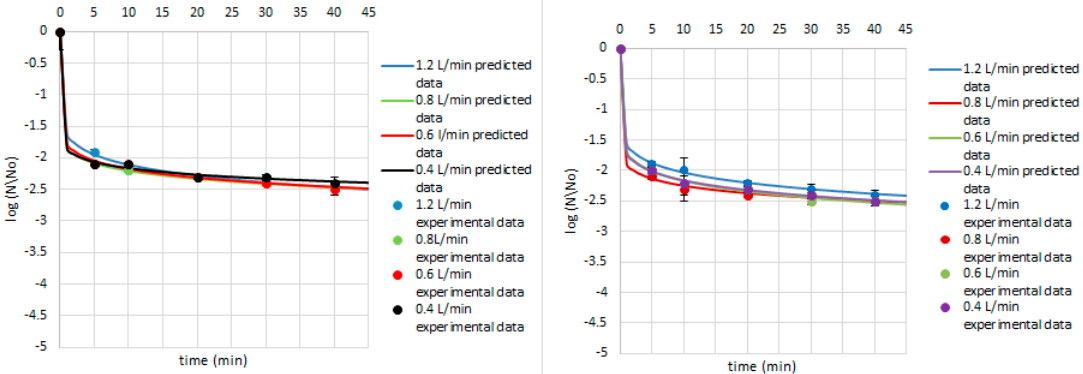
Figure 4. Survival of B. cereus on the cardamom seed ( left ) and juniper berry ( right ) matrix treated with ozone doses stimulated with flow rate of 1.2, 0.8, 0.6 and 0.4 L/min after 5, 10, 20, 30, and 40 min. Solid line: prediction of the Weibull model (egns 4–5), dotted line: bacterial log counts.